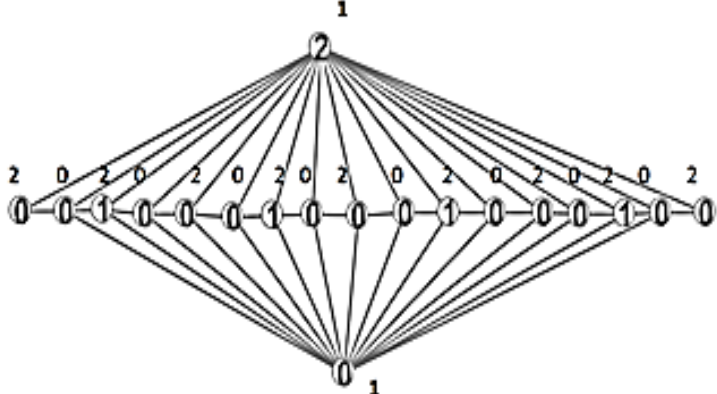
Figure 13 . Switching with modular coloring in